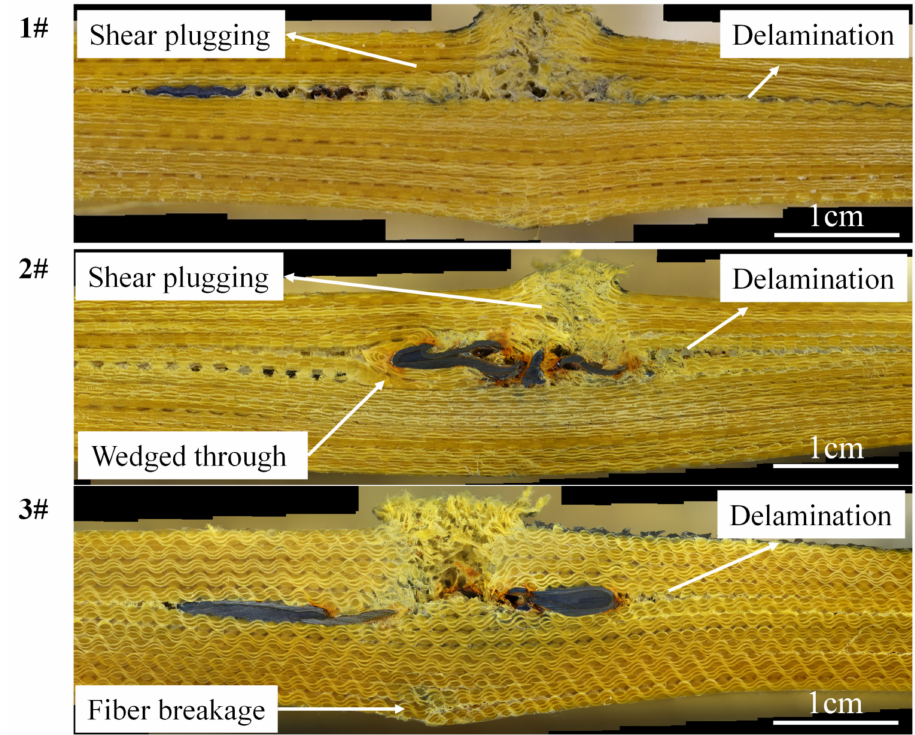
Figure 16. Cross-sectional views of three kinds of armor materials with weft density specifications at 0 ◦ firing